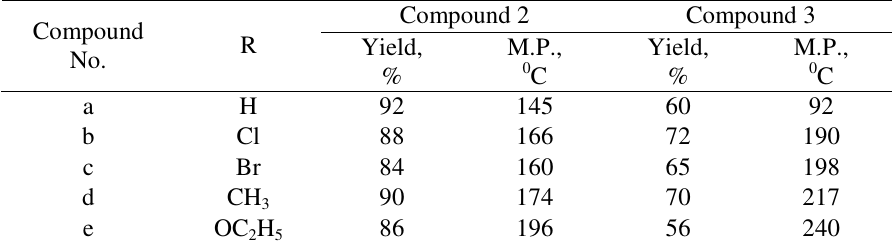
Table 1. Characterization data of synthesized compounds ( 2a-e ) and ( 3a-e ) Compound 2